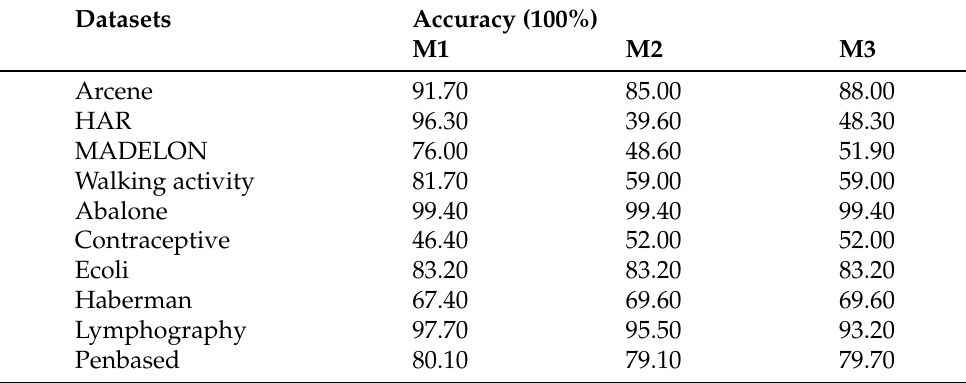
Table 5. Classification results on all datasets using neural network